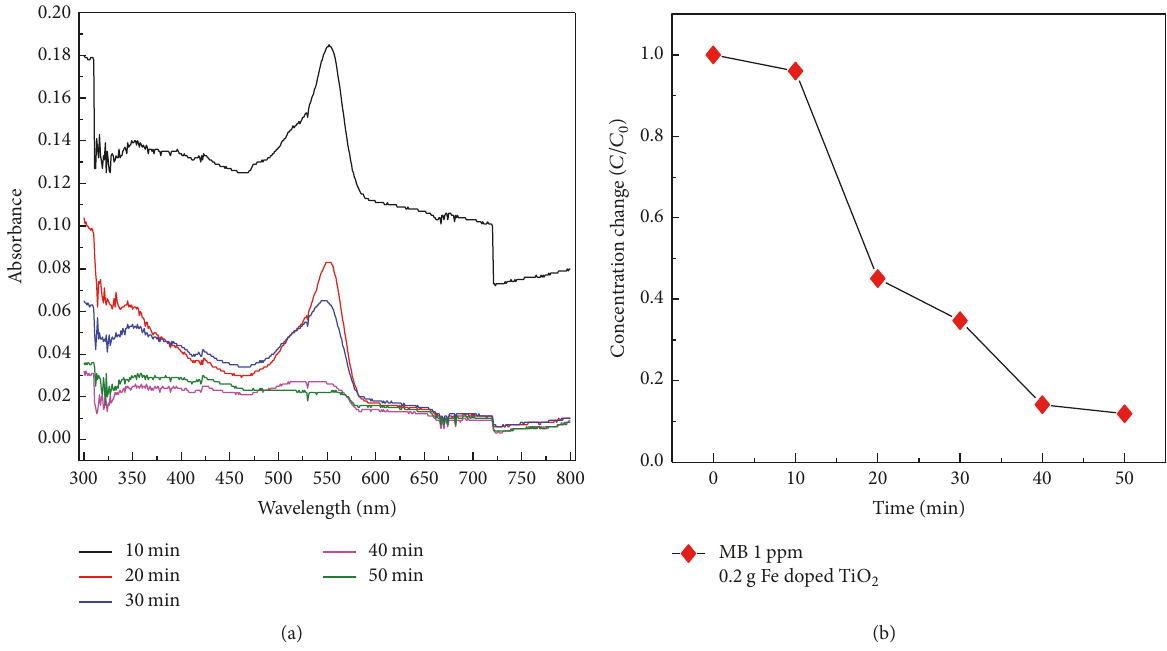
Figure 7: (a) UV-Vis spectra of the dye solution with different interval time and (b) shows the plot of concentration decreasing with time.